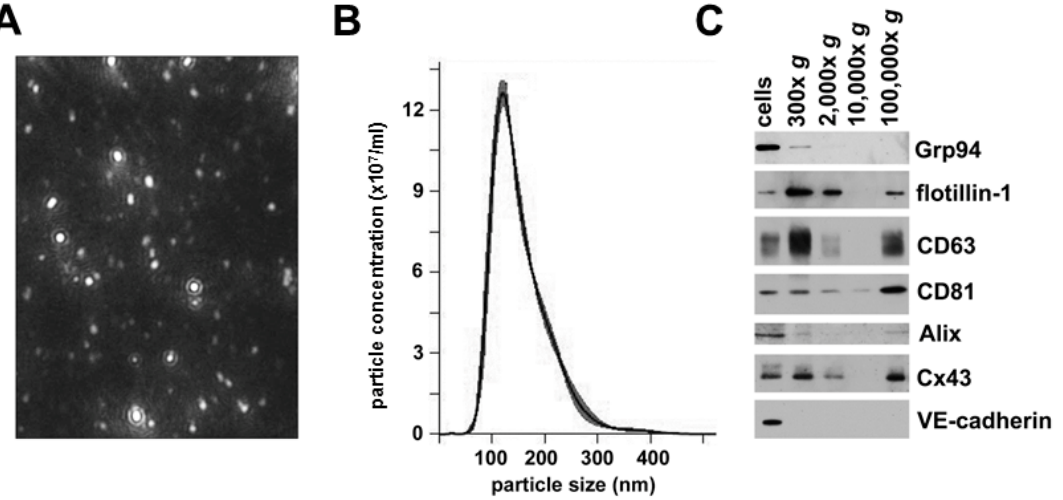
Figure 2. Vesicles secreted from cultured microvascular endothelial cells have properties consistent with identification as exosomes and contain Cx43. ( A ) Screen shot showing single frame of a video from the nanoparticle tracking analysis of the 100,000 × g material. ( B ) Graph shows a representative profile of the extracellular vesicles in the 100,000 × g pellet from the nano-tracking analysis. For this example, the mode was 120.7 nm; mean ± SD was 154 ± 54 nm; 10% of the vesicles were <98 nm; 50% were <141 nm; and 90% were <226 nm. ( C ) Immunoblots were performed on an hCMEC/D3 cell homogenate and the pellets obtained by sequential centrifugation of conditioned medium at increasing forces (300 × g , 2000 × g , 10,000 × g and 100,000 × g for the times noted in Materials and Methods). To facilitate comparisons, the gels were loaded with comparable percentages of the pellets from the sequential spins. The 100,000 × g material contained the exosomal markers (flotillin-1, CD63, CD81 and Alix) as well as Cx43, but it did not contain detectable amounts of the endoplasmic reticulum protein Grp94 or VE-cadherin.